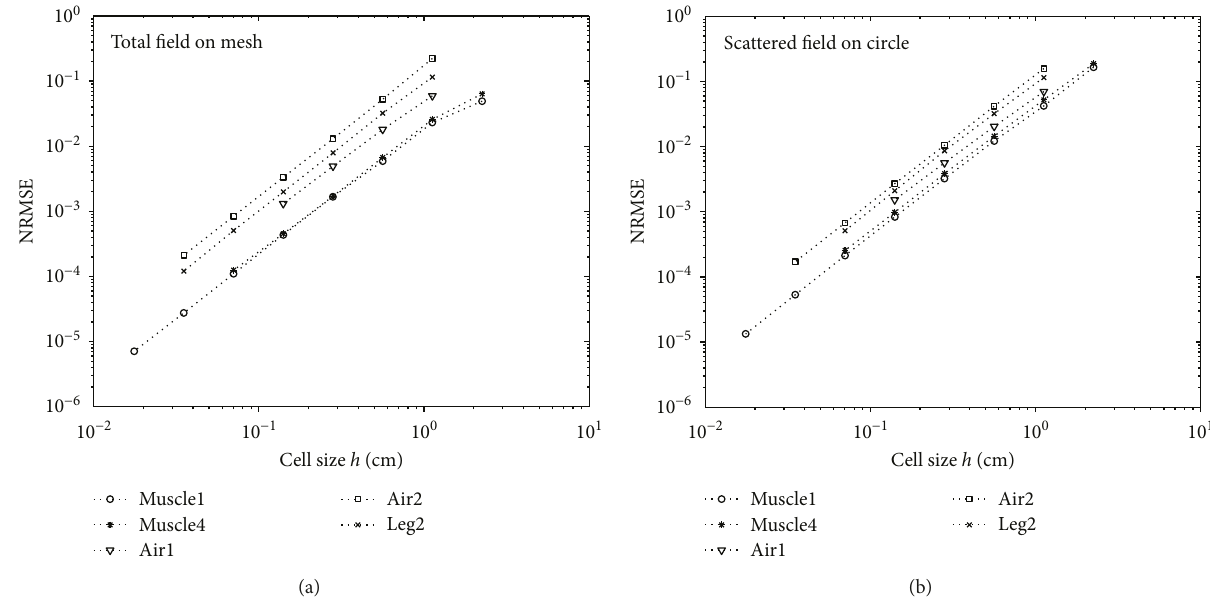
ρ , ρ Figure 3: The NRMSE for (a) G on the mesh and for (b) G scat hom S Table 1. In presence of the casing and for proper choices of M and L , the values in (a) are multiplied with a factor between 1 and 2 for the ρ , ρ , and (b) remains valid for the NRMSE of G dif NRMSE of G cas S